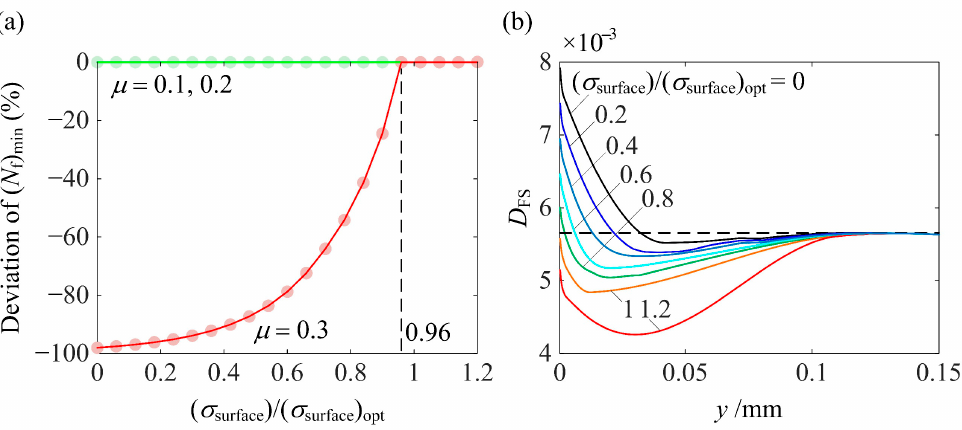
Figure 11. The percentage decrease in ( N f ) min when ( a ) y max and ( b ) y core deviate from their optimum values for P / P rated = 1 and μ = 0.1, 0.2, and 0.3.